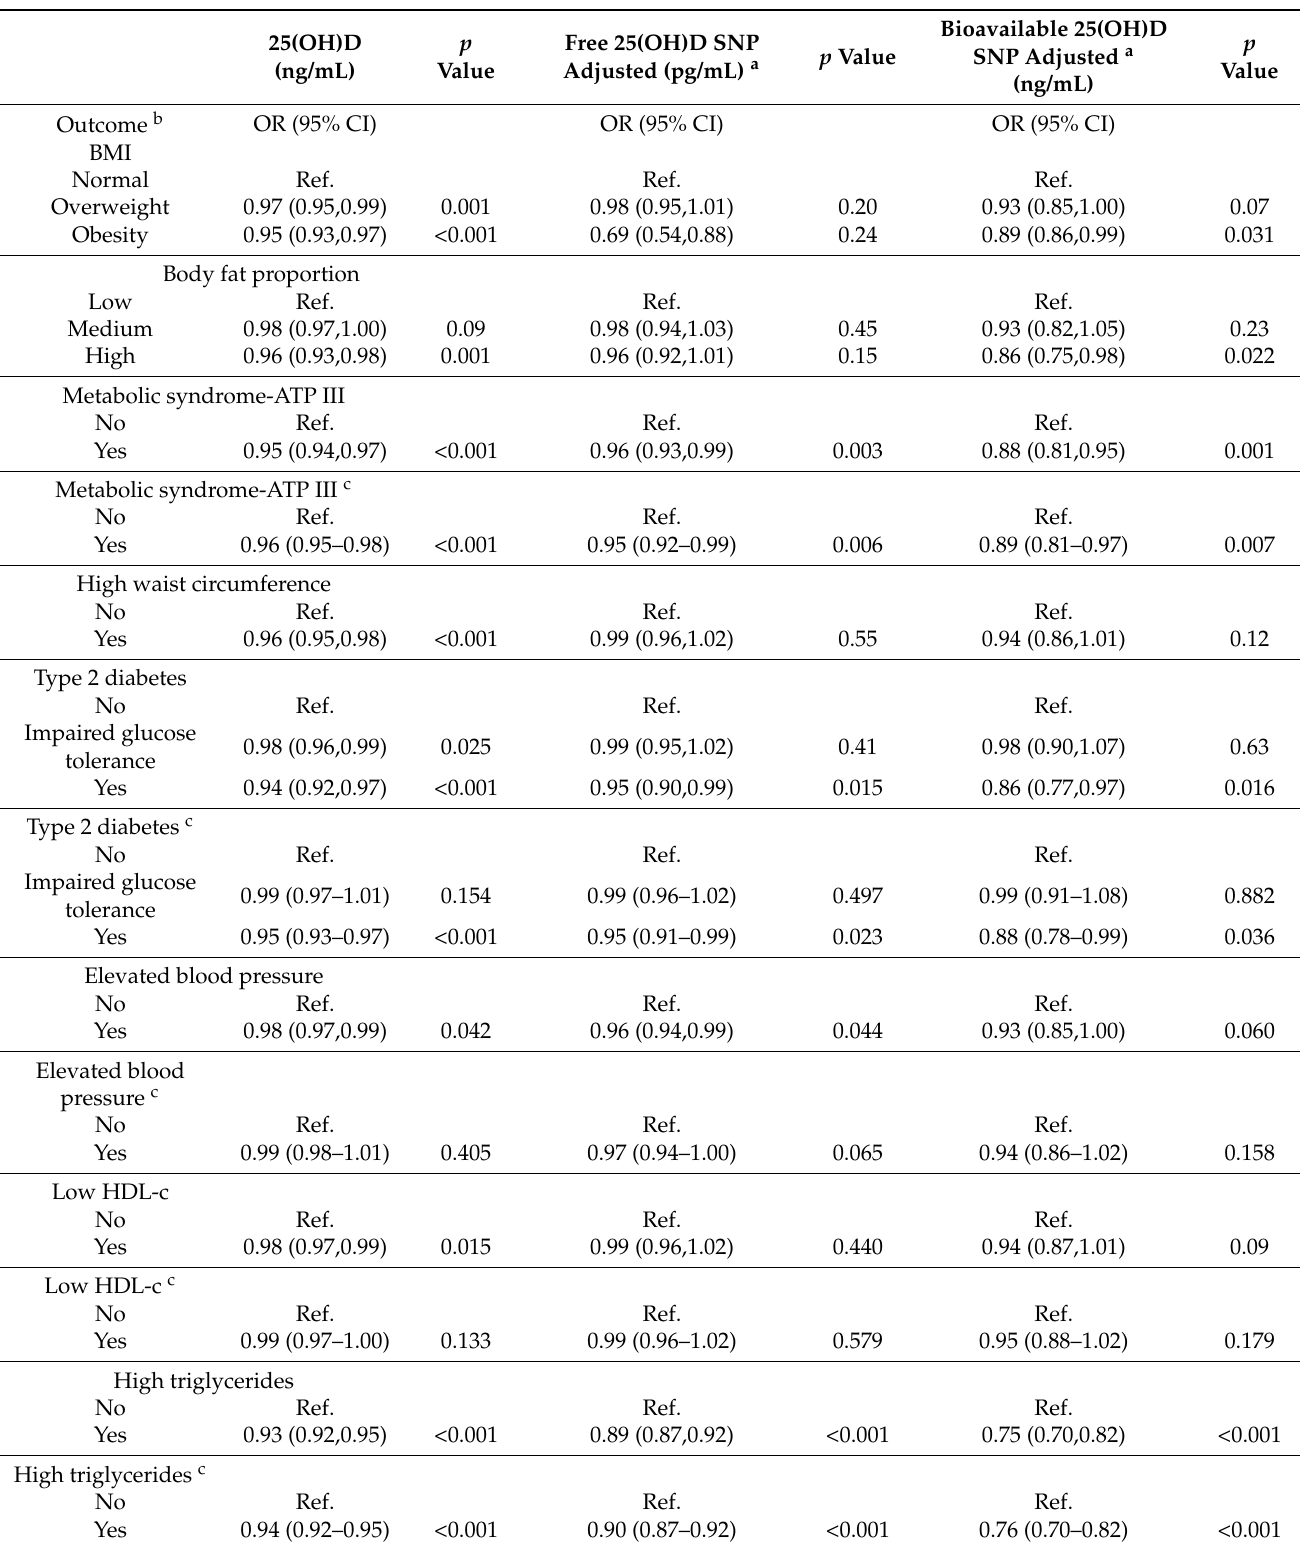
Table 3. Association between total, free, and bioavailable 25(OH)D levels, adiposity markers, and metabolic traits in the Health Workers